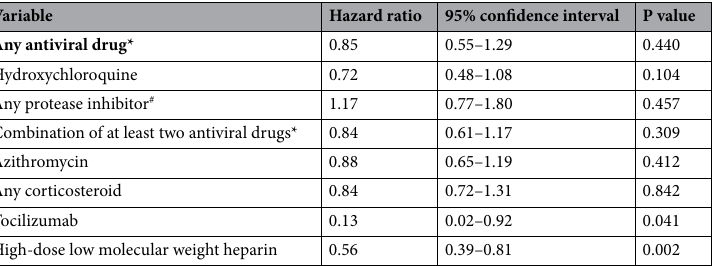
Table 1. Model-adjusted risk of mortality for medical interventions among COVID-19 patients in multivariable Cox proportional-hazards model. (N = 600). Model adjusted for age, sex, number of comorbidities, patient symptoms (cough or diarrhoea) at hospital admission, level of respiratory support needed at hospital admission, laboratory results (full blood counts of white blood cells, lymphocytes, platelets, and C-reactive protein levels) at hospital admission. *Including hydroxychloroquine, lopinavir/ritonavir, darunavir/ritonavir, darunavir/cobicistat, or remdesivir. # Including lopinavir/ritonavir, darunavir/ritonavir, or